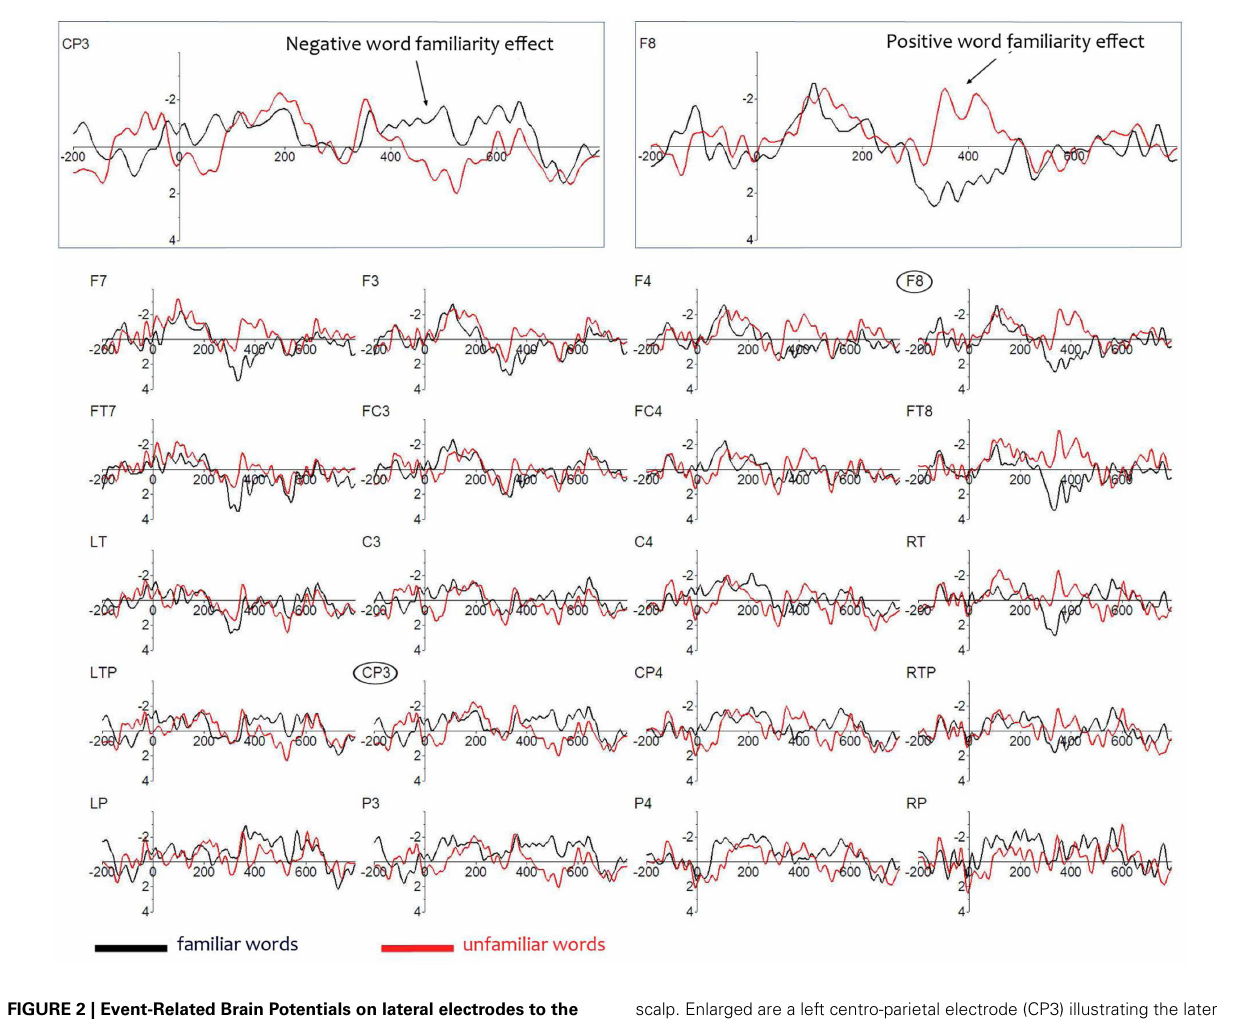
scalp. Enlarged are a left centro-parietal electrode (CP3) illustrating the later negative familiarity effect, and a right frontal electrode (F8), illustrating the earlier positive familiarity